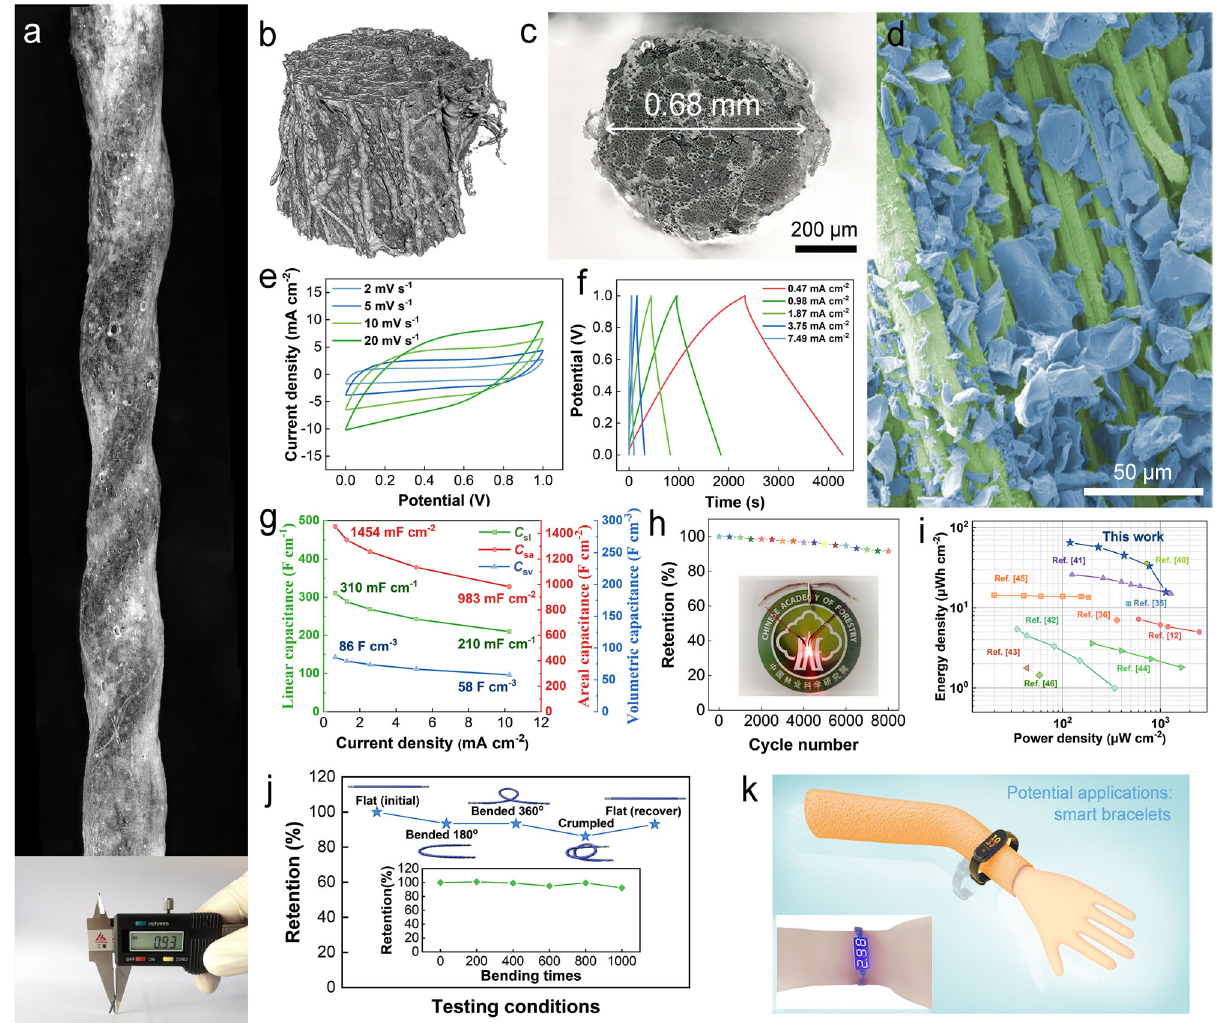
Fig. 4 Structural design of FSE and yarn FSC and their performance. a Extended depth-of- fi eld 3D image of an electrolyte-coated FSE with (inset) a diameter of 0.93 mm. b 3D nano-CT image of a 1-mm-long FSE. c Extended depth-of- fi eld 3D image of a FSE without an electrolyte coating (cross-section). d Arti fi cial-color SEM images of the rough surface and internal cavity of the BF enabling good adhesion of the PCs in a FSE. Electrochemical performance of FSCs: ( e ) CV curves at various scan rates; ( f ) GC pro fi les at different current densities; ( g ) speci fi c capacitance of FSC at different current densities; ( h ) Cycle performance of FSC with 91.6% capacitance retention after 8000 charge – discharge cycles at 7.49 mA cm − 2 using a two-electrode con fi guration; Inset: two 6.5-cm-long FSCs connected in series to power an LED indicator. i energy density and power density of FSC compared with published results: MnO 2 @AC fi bers (36.0 µW h cm − 2 ) 40 , RGO/CNT@N-doped carbon − 2 ) 36 , Ni wire@CuCo fi bers (7.2 µW h cm − 2 ) 12 , highly activated carbon fi bers fi bers (11.2 µW h cm − 2 ) 35 , Ni wire/NiCo 2 O 4 /MnO 2 (7.0 µW h cm 2 S 4 (26.0 µW h cm − 2 ) 41 , PET/Au/Ni-MOF@carbon yarn (5.41 µW h cm − 2 ) 42 , CNT@ordered mesoporous carbon (1.77 µW h cm − 2 ) 43 ,CNTs/PEDOT:PSS (3.6 µW h cm − 2 ) 44 , CNFs/RGO@PPy (14.37 µW h cm − 2 ) 45 , RGO@MoS 2 @P (1.44 µW h cm − 2 ) 46 ; j Capacitance retention of a 6.5 cm-long FSC under various mechanical deformation conditions; inset: capacitance retention after 1000 bending (360°) cycles. k Photograph of our wearable wristband and the potential applications of such wearable devices, like smart